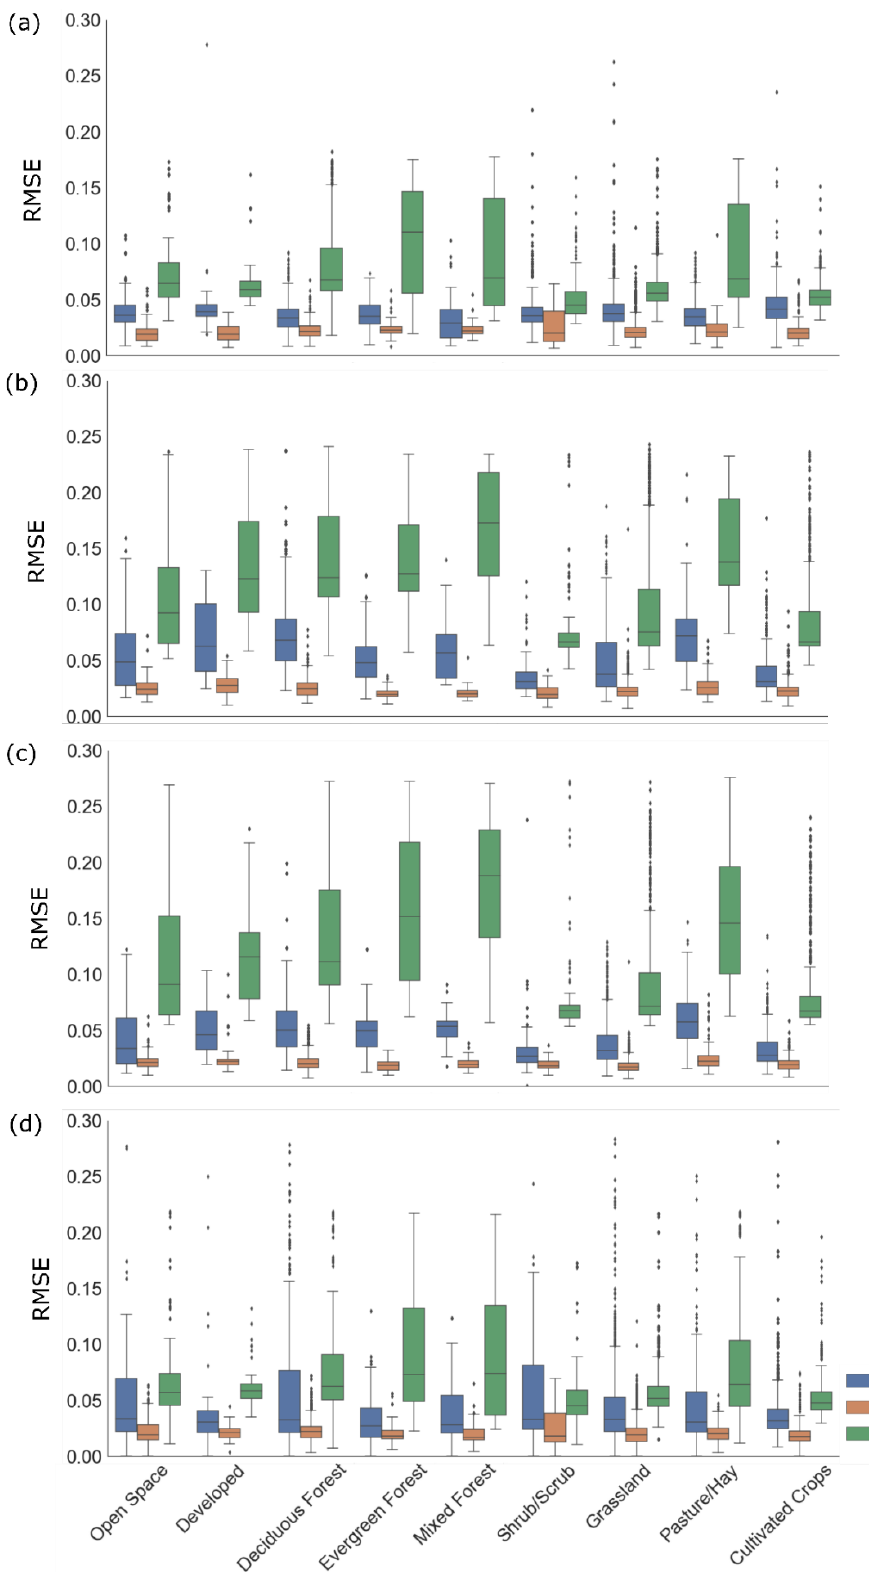
Figure 11. Mean RMSE between each soil moisture product and the TC-derived “unknown truth” at local 6 a.m., for nine Oklahoma state representative land cover types (see Table 3). Results are discretized by season: ( a ) spring, ( b ) summer, ( c ) fall, and ( d ) winter for the period from April 2015 to July 2019.